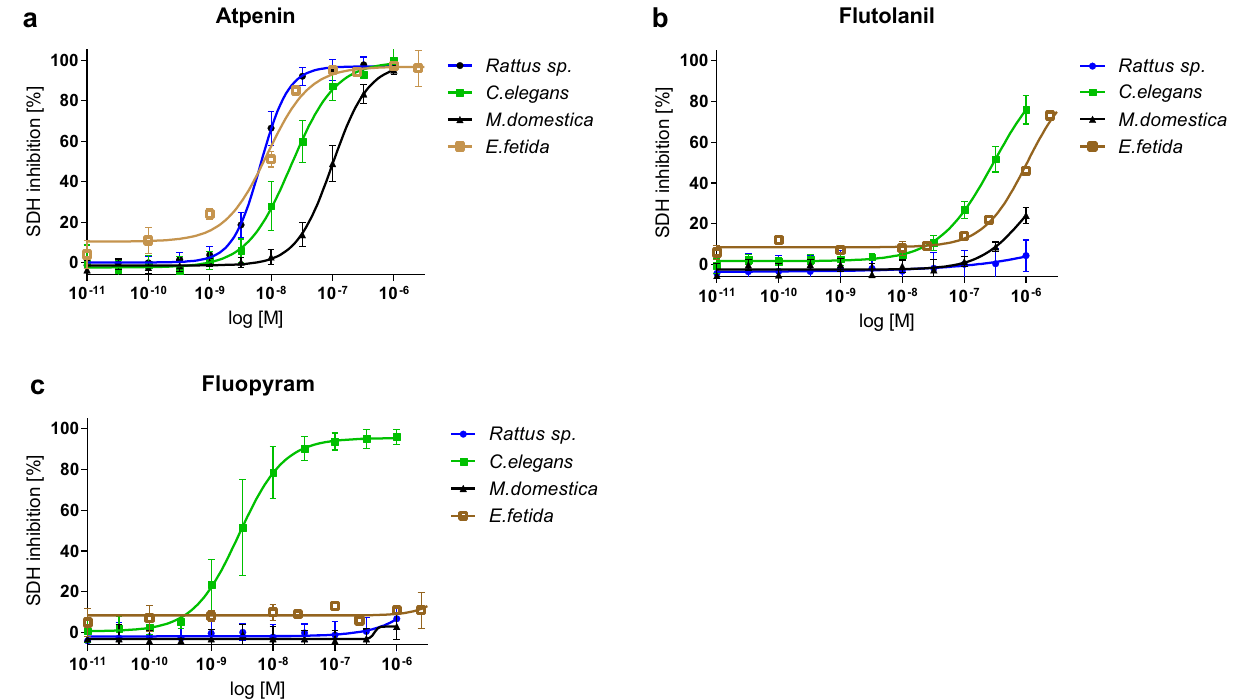
Figure 5. Inhibition of SDH activity. The efficacy of atpenin ( a ), flutolanil ( b ) and fluopyram ( c ) in inhibiting SDH activity was measured using mitochondrial preparations from house fly ( Musca domestica , black line), rat ( Rattus sp., blue line), earthworm ( Eisenia fetida subsp. andrei , brown line), and nematode ( C. elegans , green line). Values represented as mean ± SE of duplicates from three or four independent biological replicates. The following pIC 50 values were calculated: ( a ) SDH of C. elegans , rat, fly, and earthworm were inhibited with an efficacy of pIC 50 = 7.7, 8.2, 7.0 and 8.1, respectively, by Atpenin A5. (b) Flutolanil possesses a pIC 50 of 6.5 and 6.0 against C. elegans and E. fetida , respectively. ( c ) Fluopyram inhibits nematode SDH with an efficacy of pIC 50 = 8.5. pIC 50 values are not given in case they are outside the measured concentration